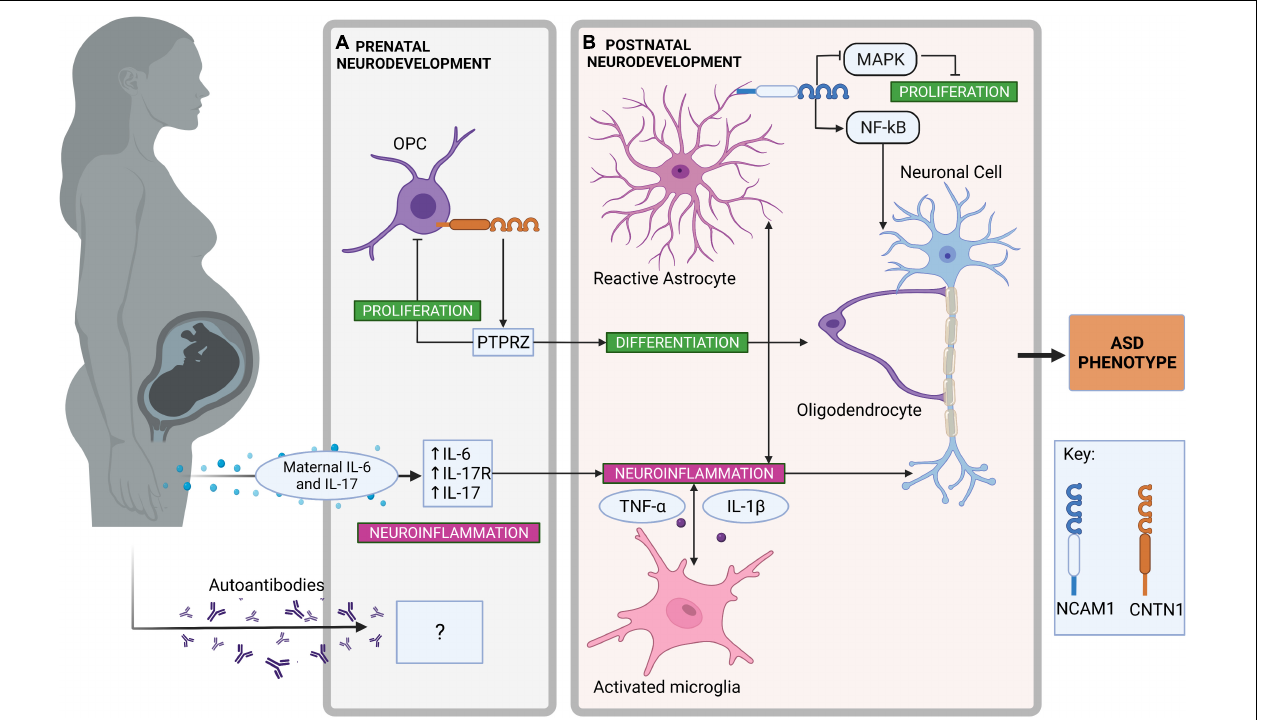
FIGURE 2 | Neuroinflammatory pathways in prenatal and postnatal neurodevelopment contributing to autism spectrum disorder (ASD). (A) Neuroinflammatory pathways in prenatal neurodevelopment. Contactin-1 (CNTN1), expressed on the surface of oligodendrocyte precursor cells (OPC) promotes OPC differentiation to oligodendrocytes by interacting with receptor protein tyrosine phosphatase zeta (PTPRZ) (250, 258). Simultaneously, OPC proliferation is inhibited by the same PTPRZ interaction (250). The transfer of maternal proinflammatory cytokines such as interleukin (IL)-6 and IL-17 via maternal immune activation can promote neuroinflammation during prenatal neurodevelopment (115, 121). As a result, increased receptor IL-17 (IL-17R) expression is found within the fetal brain, enhancing further neuroinflammatory signaling (107). Although there is some evidence for autoimmune antibodies in association with ASD, their origin and effect on neuroinflammation in the developing ASD brain is unclear (140). (B) Neuroinflammatory pathways in postnatal neurodevelopment. Astrocytes are activated by proinflammatory cytokines and neuroinflammation in the central nervous system (227). Neural cell adhesion molecule-1 (NCAM1) expressed on the surface of astrocytes can activate nuclear factor- κ B (NF- κ B)-mediated transcription of proinflammatory genes (123). NCAM1 can also inhibit astrocyte proliferation through the inhibition of mitogen-activated protein kinase (MAPK) signaling (237). Changes to OPC proliferation have been observed in ASD brains, which can alter the production of myelin and possibly expose neuronal cells to inflammatory insult (146). Microglia are also activated by proinflammatory cytokines and neuroinflammation in the central nervous system (220). Activated microglia to produce proinflammatory cytokines including IL-1 β and tumor necrosis factor (TNF)- α (39). Created with